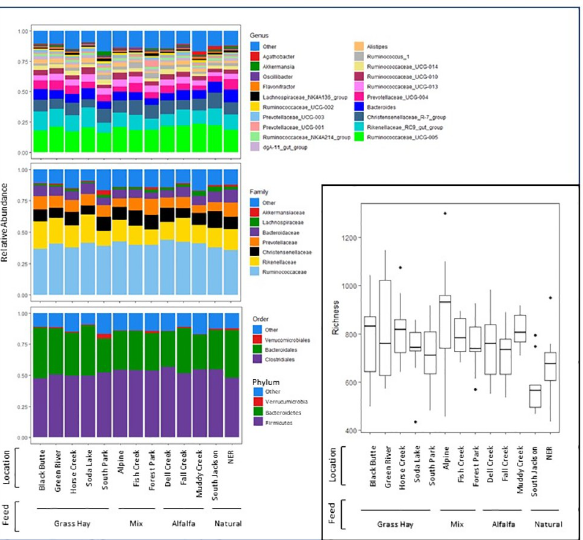
Fig 2. Relative abundance for the top 20 most abundant genera are shown for each population in the cross- sectional study. Fill color indicates genus (top left), family (middle left) or order/phylum (bottom left). Amplicon sequence variant-level richness and alpha diversity for each population is shown in the inset (bottom right) where the midline indicates the median values, hinges indicate the first and third quartiles, whiskers extend up to 1.5 the interquartile range, and outliers beyond this range are represented as individual points. Populations are grouped by diet at the time of sample collection. Note that cross-sectional samples from the National Elk Refuge (NER) were collected prior to commencement of feeding at that location.